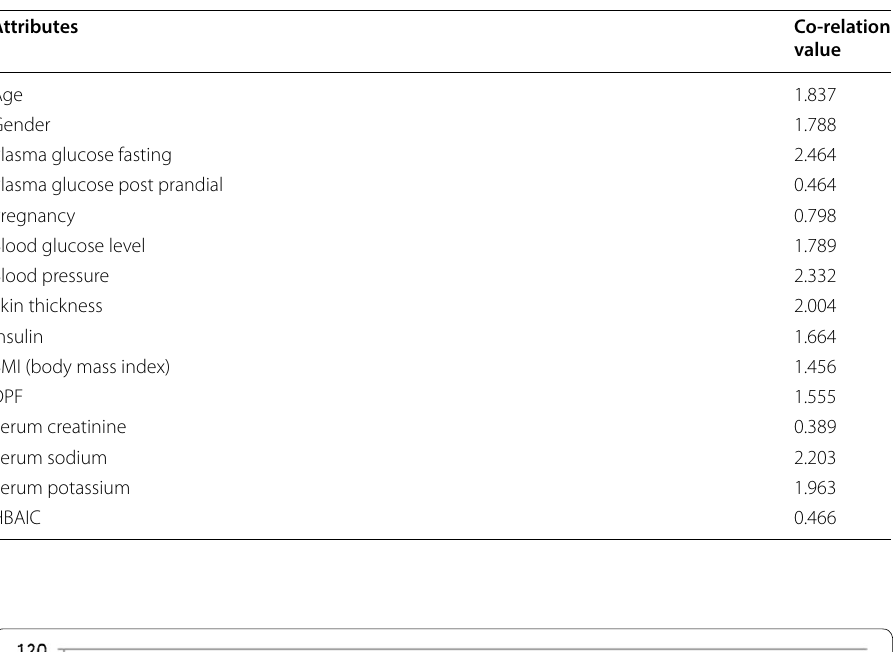
Table 9 Results-selection optimal attributes